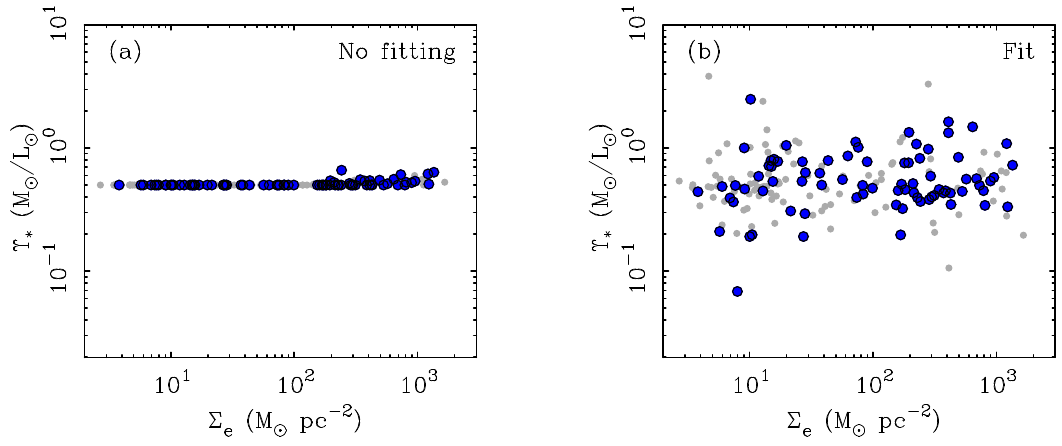
Figure 7. The effective surface densities of SPARC galaxies and their stellar mass-to-light ratios as obtained ( a ) from assuming constant Υ ∗ = 0.5 M (cid:12) /L (cid:12) at [3.6] for stellar disks and Υ ∗ = 0.7 M (cid:12) /L (cid:12) for bulges, and ( b ) by fitting rotation curves [112]. Large blue points are galaxies with distances known to better than 20%; smaller grey points are galaxies with less accurate distances. The absence of scatter in ( a ) is anathema to stellar populations; there must be some intrinsic scatter in this quantity from variations in the star formation history from galaxy to galaxy. The scatter seen in ( b ) is consistent with that expected from intrinsic scatter in Υ ∗ [47,61,62] and observational uncertainties